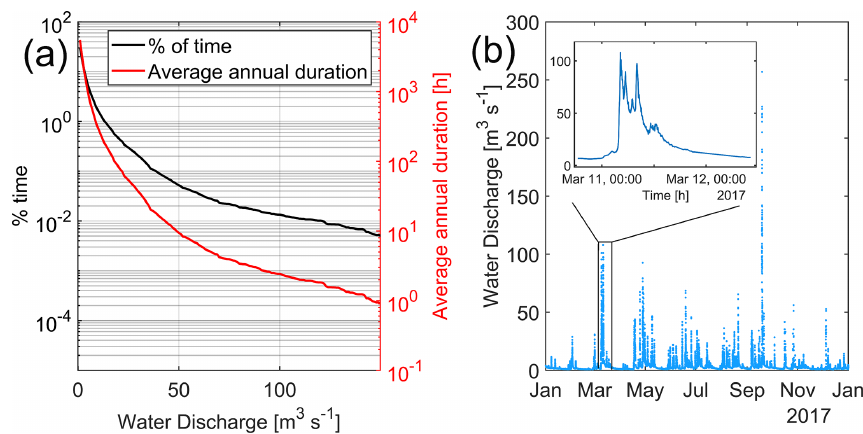
Figure 2. (a) Percentage of time during which the Vieux-Habitants river stays above a given discharge. This distribution is calculated from the data acquired between 2011 and 2018 at the Barthole station. (b) Hydrograph of the Vieux-Habitants river during the year 2017. The high peak in September 2017 corresponds to Hurricane Maria, which struck Guadeloupe on 19 September 2017. During this hurricane, the discharge reached up to 263m 3 s − 1 . Inset: typical flood event.